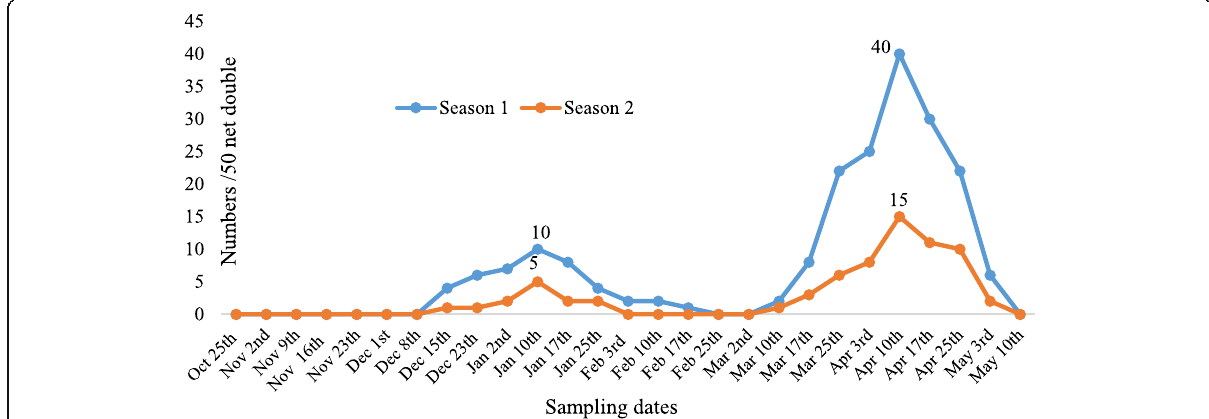
Fig. 2 Numbers of H. brunneipennis (EAW) adults/50 net double strokes in season 1 (2016/2017) and season 2 (2017/2018) after applying B. bassiana in season 1 (arrow)